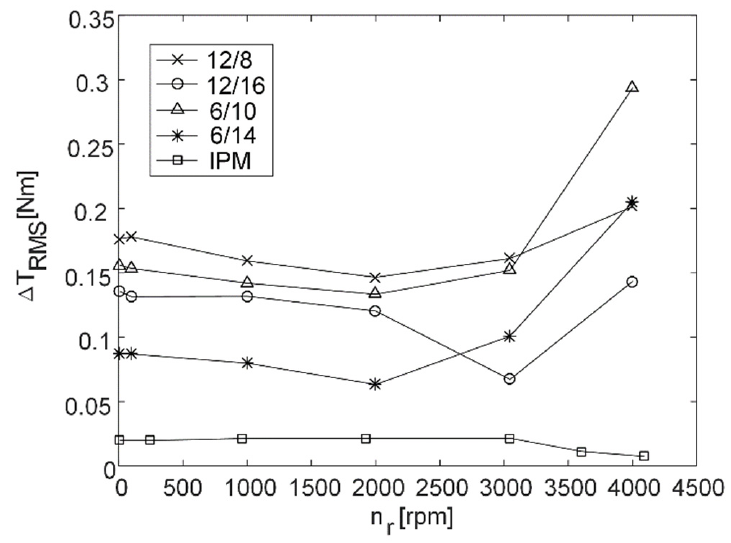
Figure 17. Torque ripple values at different speeds and maximum current.